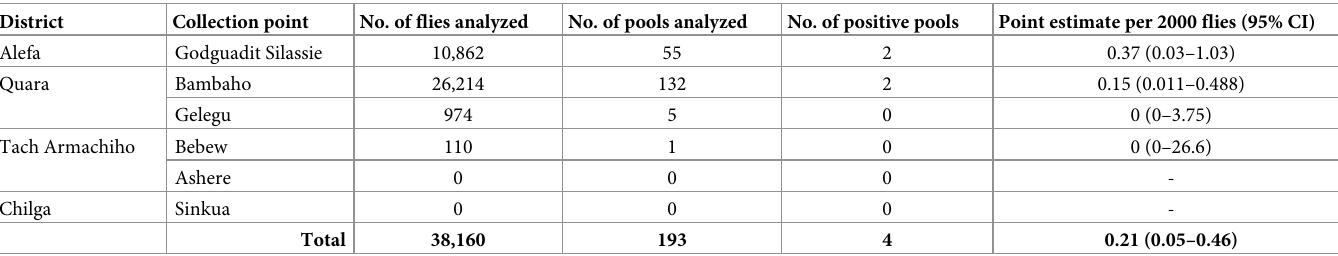
Table 5. PCR Results for O . volvulus DNA in Simulium flies collected in and around the Buffer Zone (2016 and 2017).